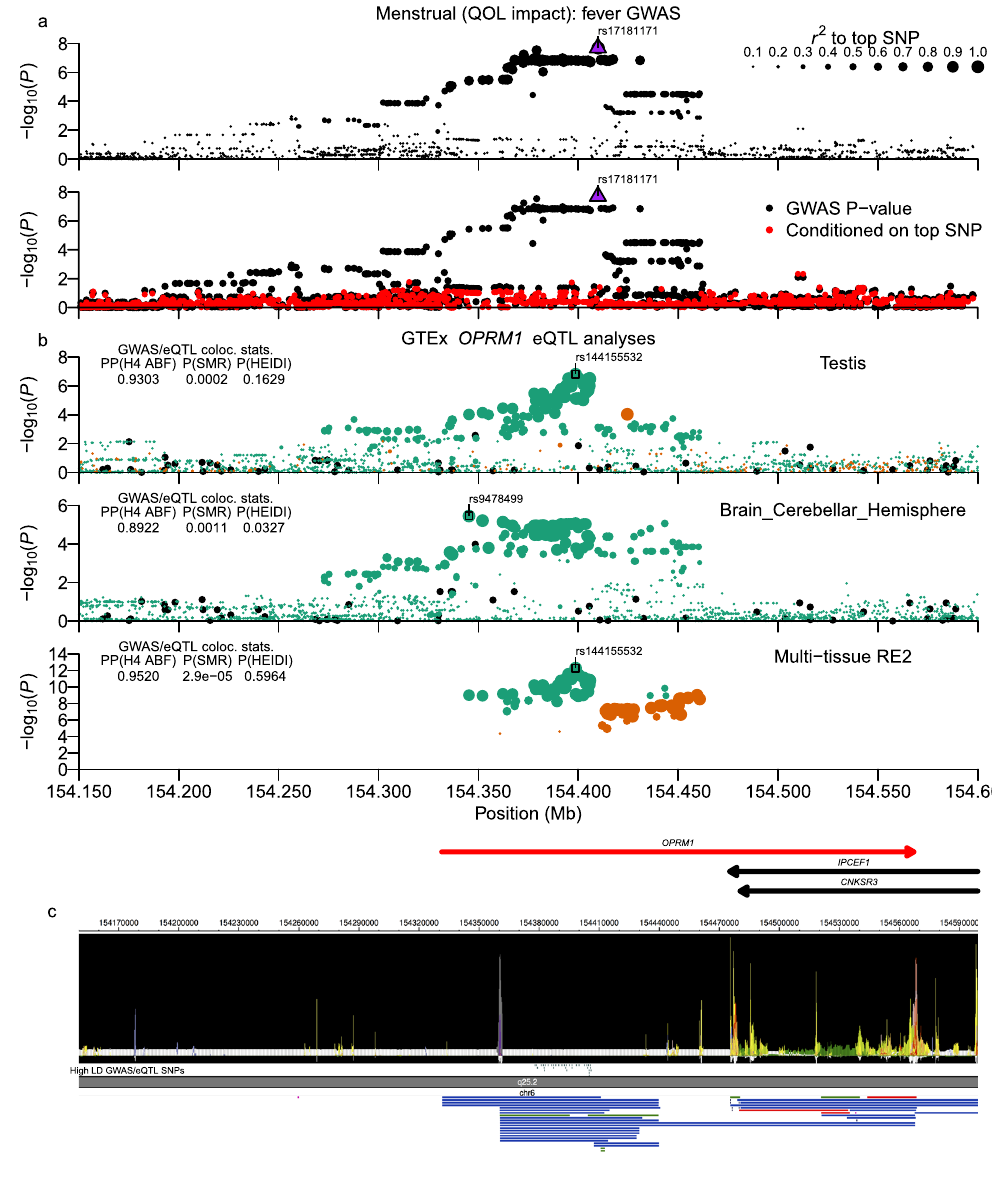
Figure 5. Menstrual fever (QOL impact) chr6:154.33–154.46 Mb ( OPRM1 ) locus. Plot is configured the same as Fig. 1. ( b ) shows analyses of GTExPortal OPRM1 eQTL data. The ABF colocalization method was run using β -coefficients and standard errors. Candidate causal SNPs shown in ( c ) are SNPs with r 2 to top eQTL signal SNPs for brain cerebellar hemisphere and testis tissue